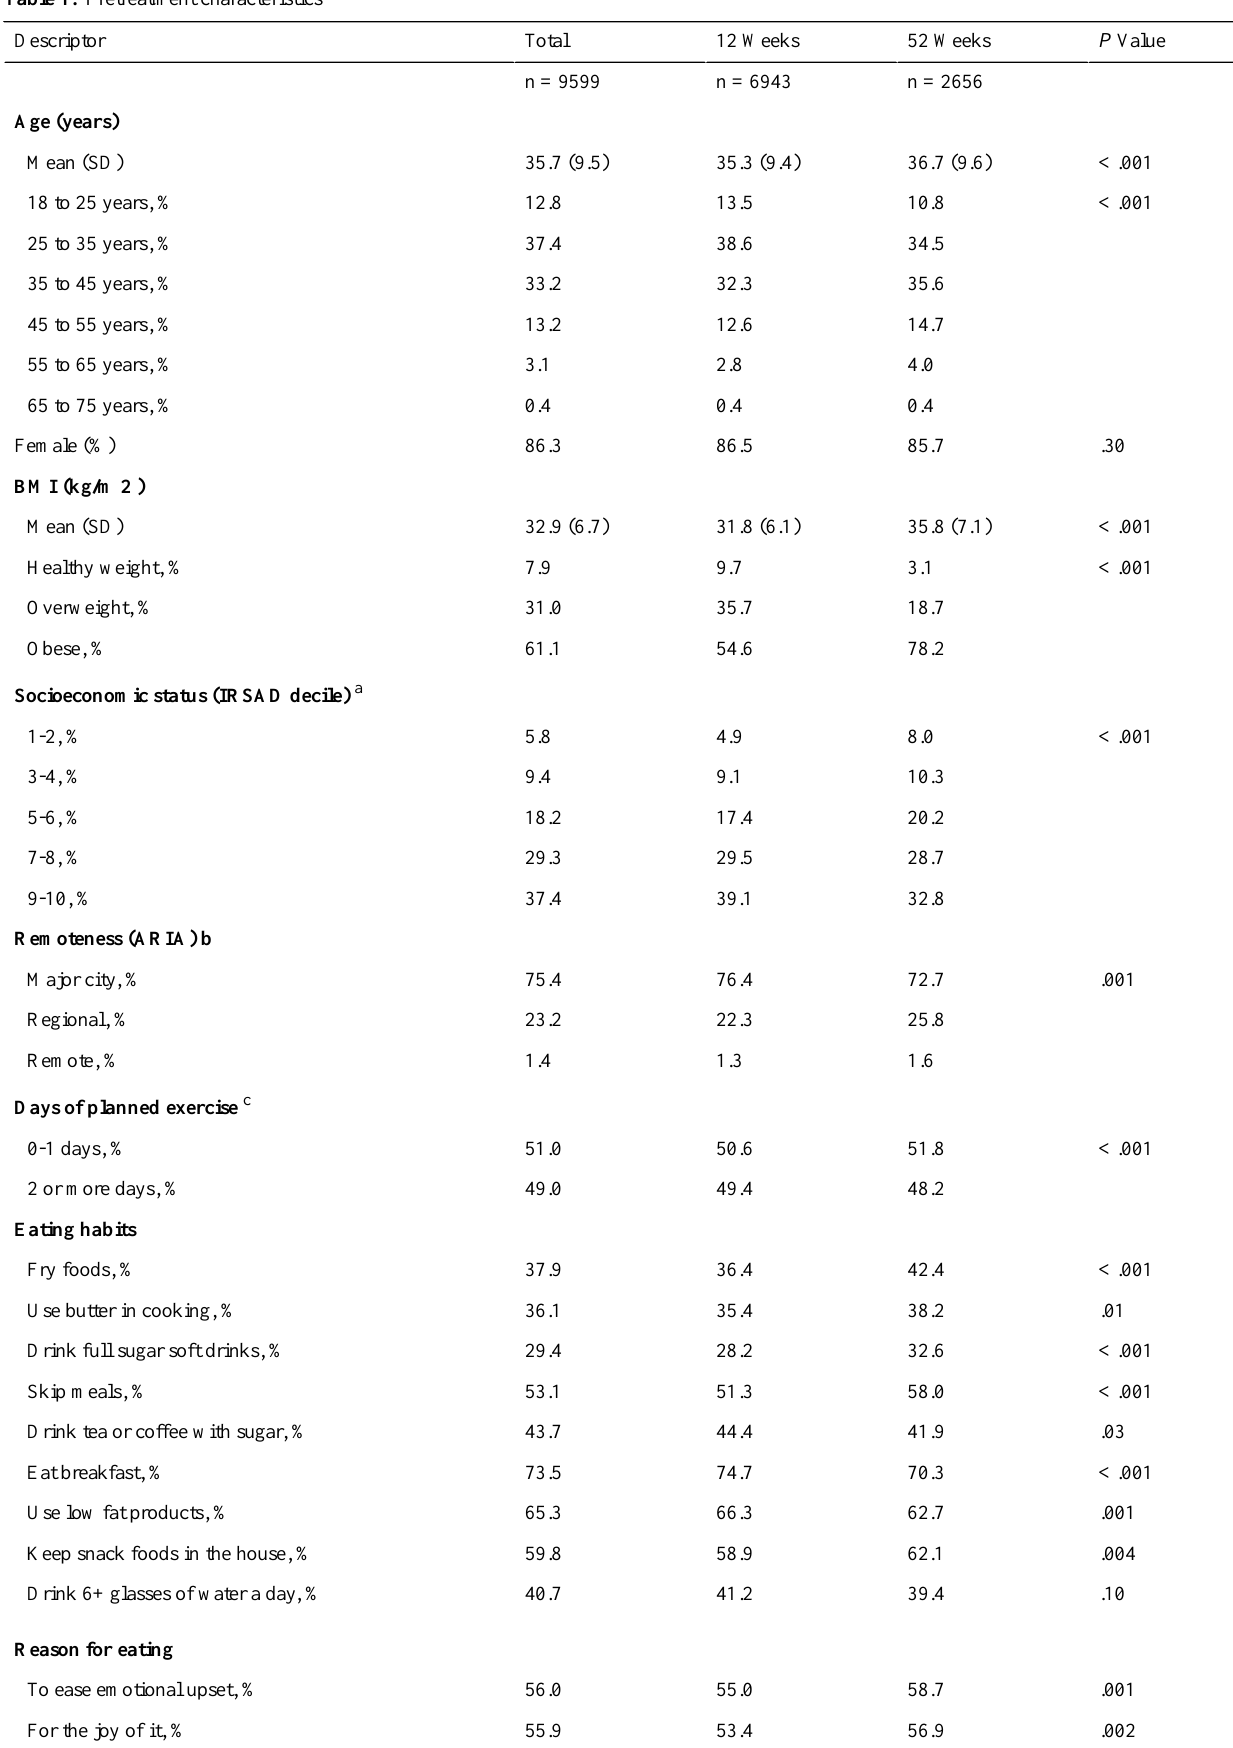
Table 1. Pretreatment characteristics